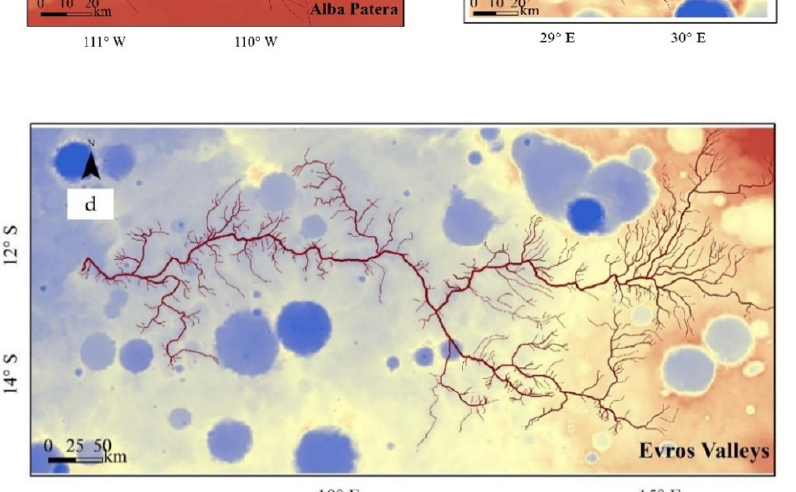
Figure 4. The extracted valley networks in the Qaidam Basin and on Mars. ( a ) The Manya river is in the Qaidam Basin. ( b ) The Alba Patera valley is the Amazonian valley network on Mars. ( c ) Naktong Vallis is the Hesperian valley network. ( d ) Evros Vallis is the Noachian valley network. The age of a valley network is determined by crater counting [8,9]. The base map is MOLA DEM data.